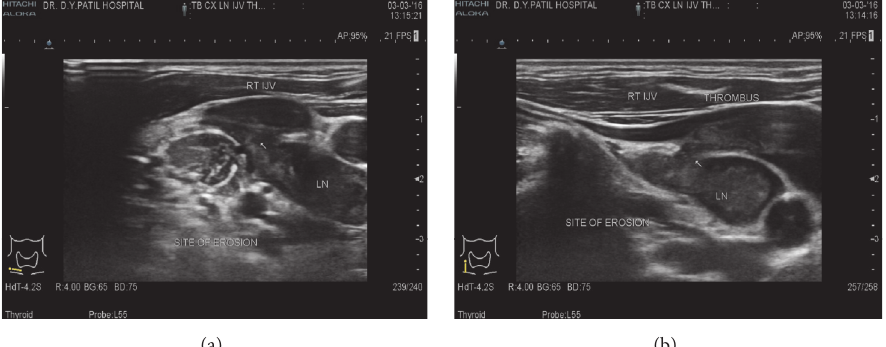
Figure 2: Cervical lymph node at level IV eroding through posterior and the right lateral wall of IJV with medium level echogenic IJV thrombus.